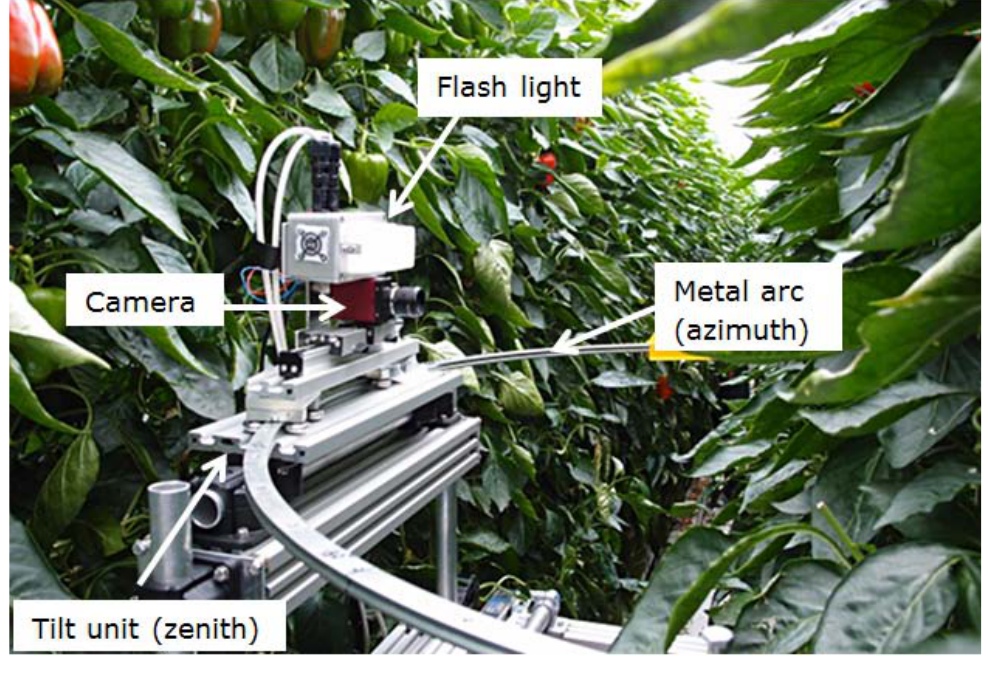
Figure 1. ( a ) Photo of the camera setup in the crop row, with azimuth = 90° and zenith =